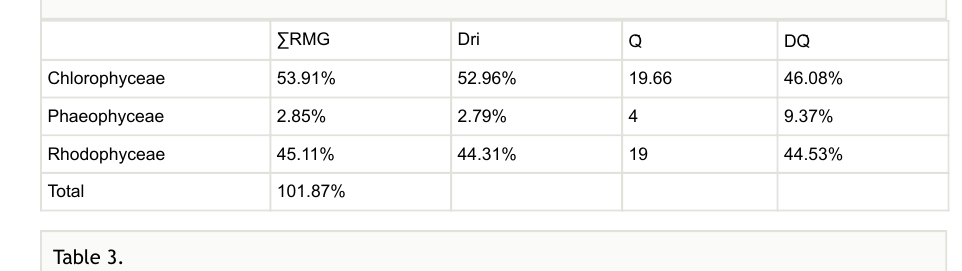
Analytical parameters at the Salamandre Station.